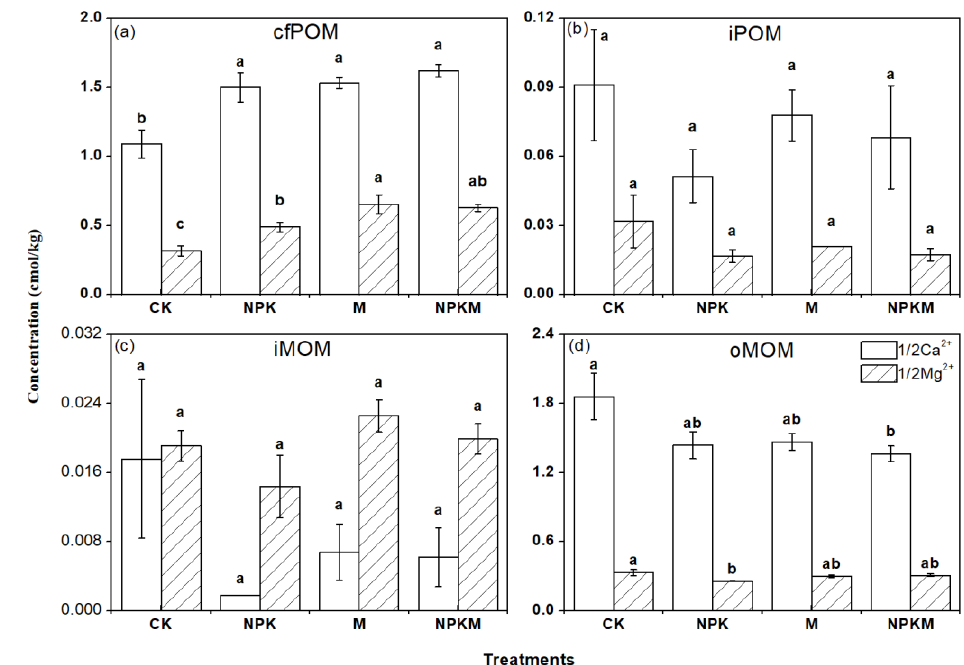
Figure 5. The value of SIC/SOC in different aggregates: ( a ) cfPOM; ( b ) iPOM; ( c ) iMOM; ( d ) oMOM. cfPOM means coarse free particulate organic matter fraction, iPOM means particulate organic matter inner microaggregate, iMOM means mineral-associated organic matter inner microaggregate, and oMOM means mineral-associated organic matter outer fraction. Error bars represent the standard deviations of the mean ( n = 3). Different characters above bars indicate significant differences among the treatments at p < 0.05.